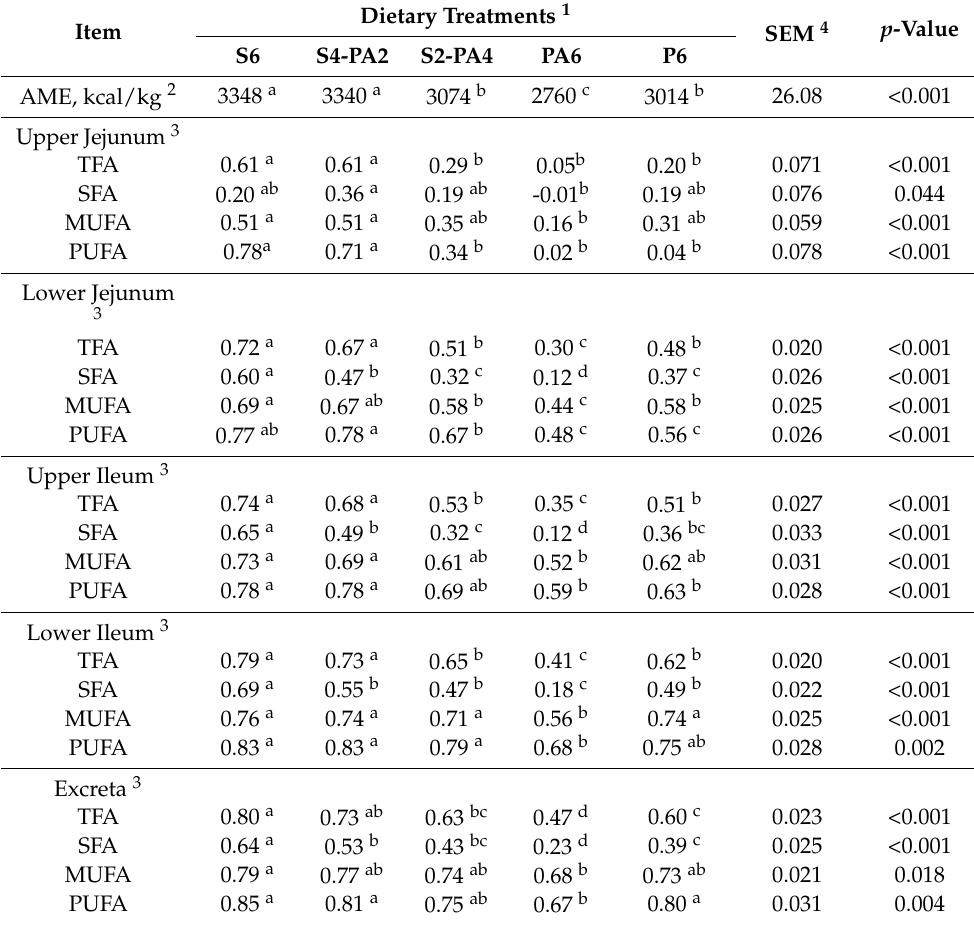
Table 7. Feed apparent metabolizable energy values and apparent fatty-acid digestibility coefficients along the intestinal tract and excreta according to different fat sources in the diet in 11-d-old broiler chickens.